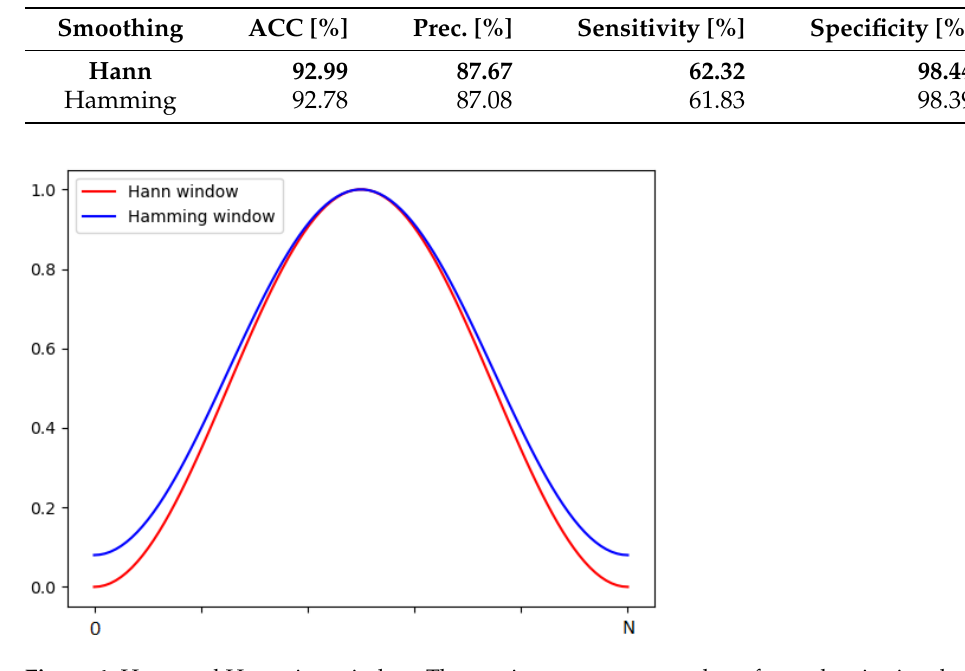
Figure 4. Hann and Hamming window. The x-axis represents a number of sample n in signal.